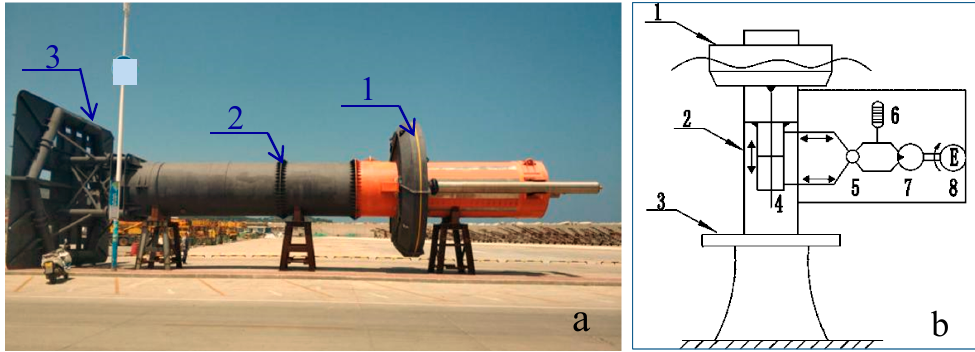
Figure 1. The heaving float wave energy power generation device. ( a ) Bracing and agent architectures, ( b ) work principle sketch diagram.